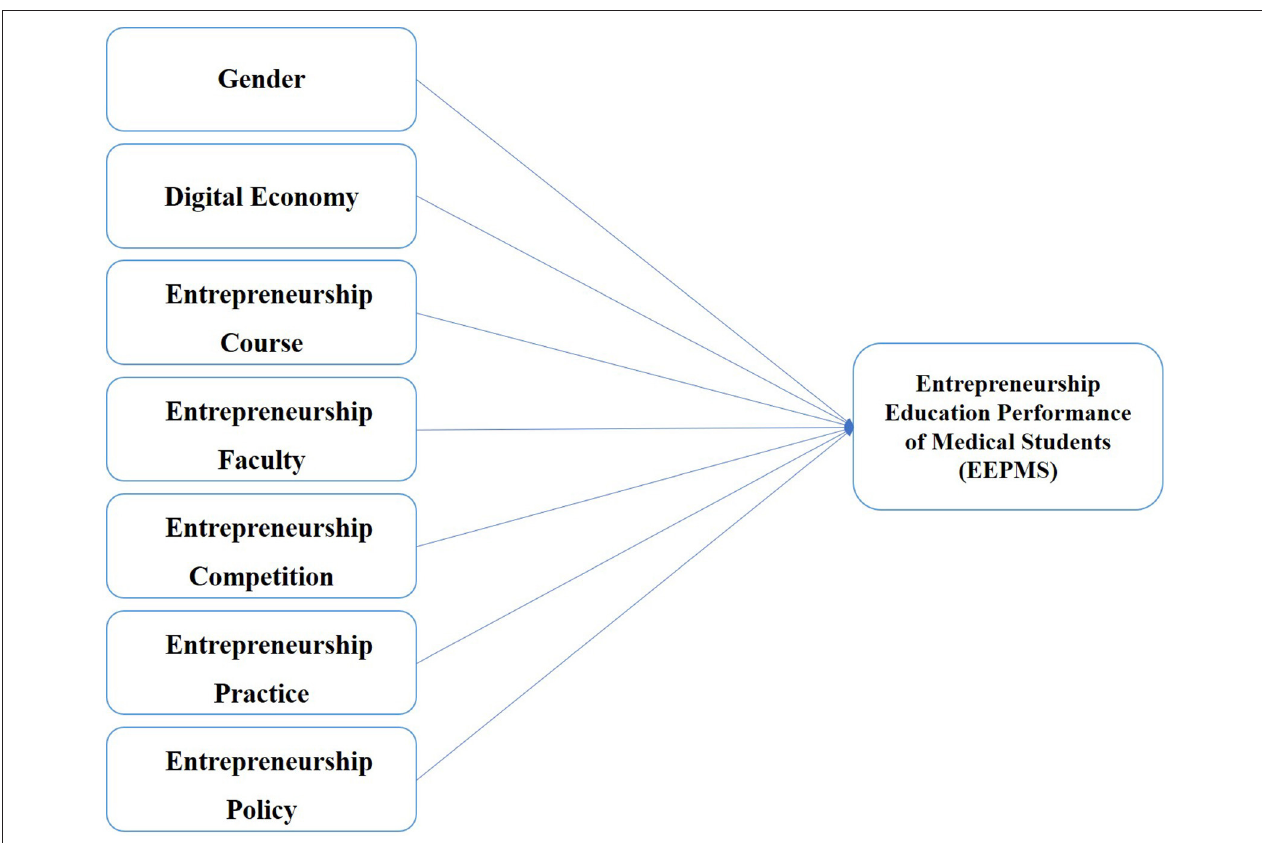
FIGURE 1 | Research framework of